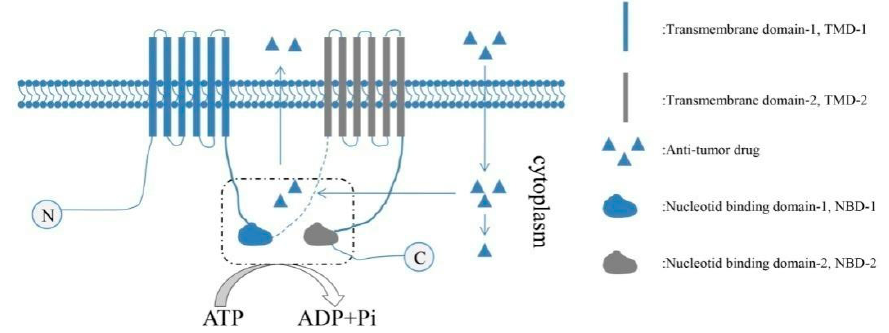
Figure 2. An ABC transporter is composed of two transmembrane domains (TMD-1 and TMD-2) and two nucleotide-binding domains (NBD-1 and NBD-2). As shown in the figure, chemotherapeutic drugs could be pumped out of tumor cells via the ABC transporter expressed on CSCs.